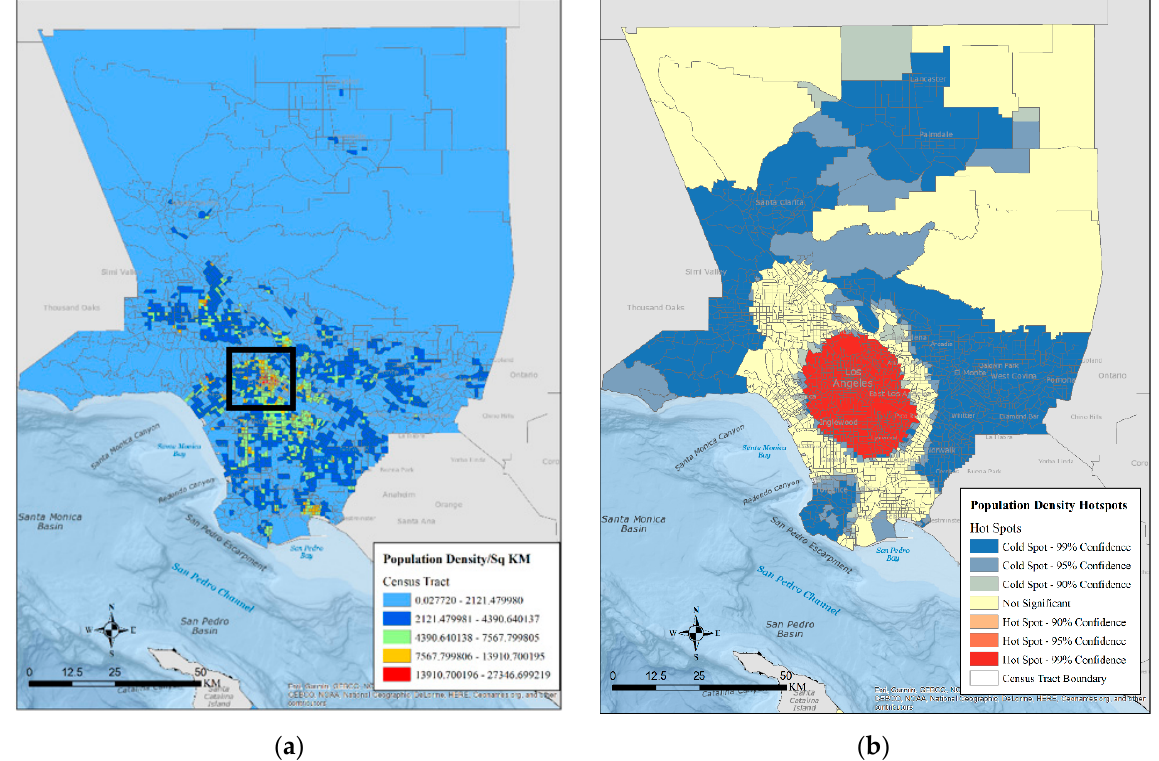
Figure 2. Population density distribution at the census tract in LA County (population/square KM) ( a ) and high- and low-density census tract clusters in LA County ( b ).